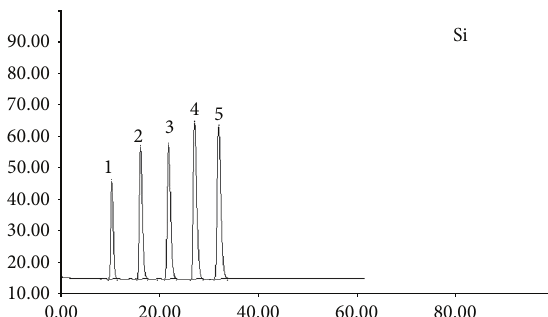
Figure 3: Gas chromatographic separation of paraffinic hydrocar- bons on parent silica stationary phase, at optimum conditions (60 ∘ C , and (c) Si . C500 C for 2min; 15 ∘ C/min to 220 ∘ C; final time 10min, 30mL/min).